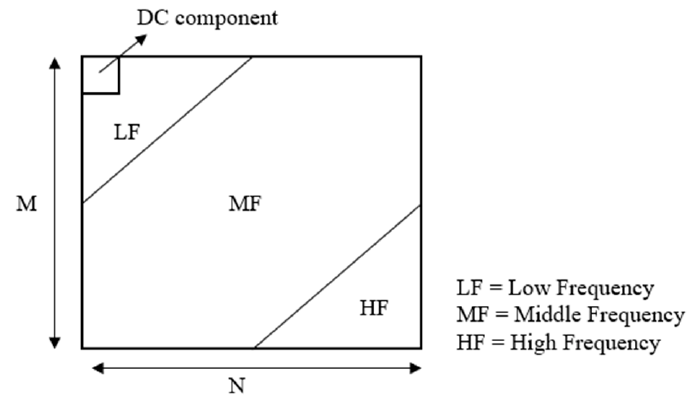
Figure 3. Discrete cosine transform (DCT) coefficients of an image of size M × N.